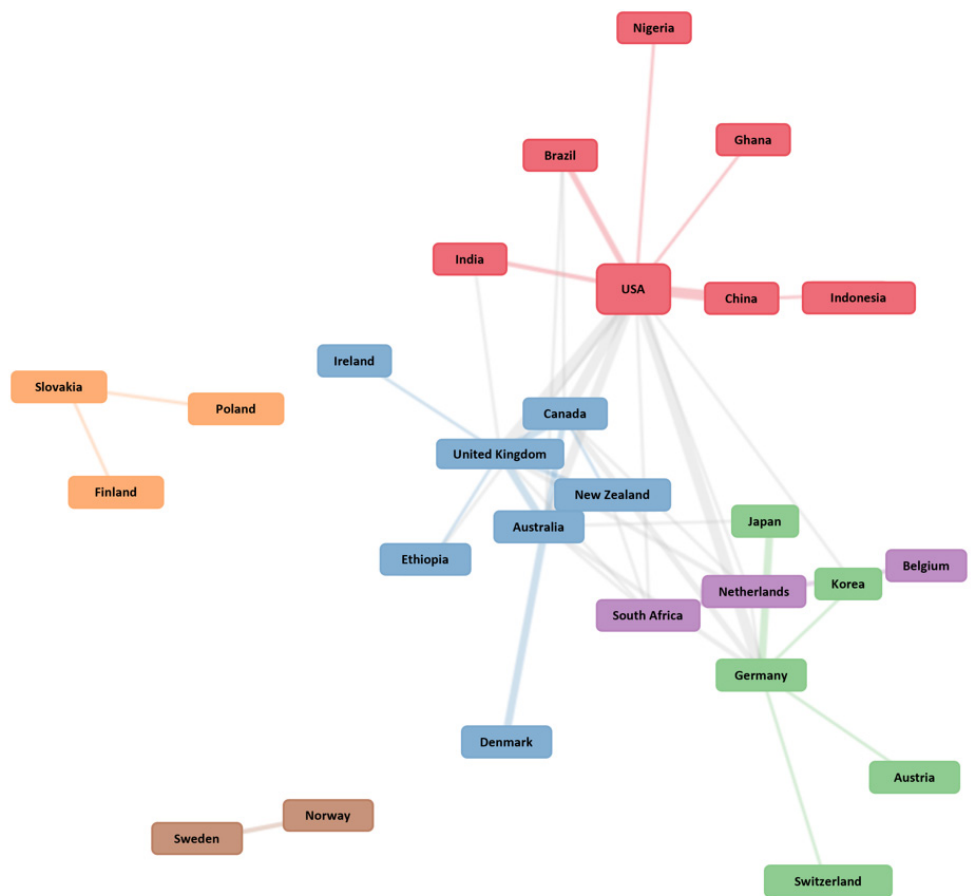
Figure 7. Countries’ collaboration network. Each color indicates a specific cluster and their relation- ship within or with other clusters.